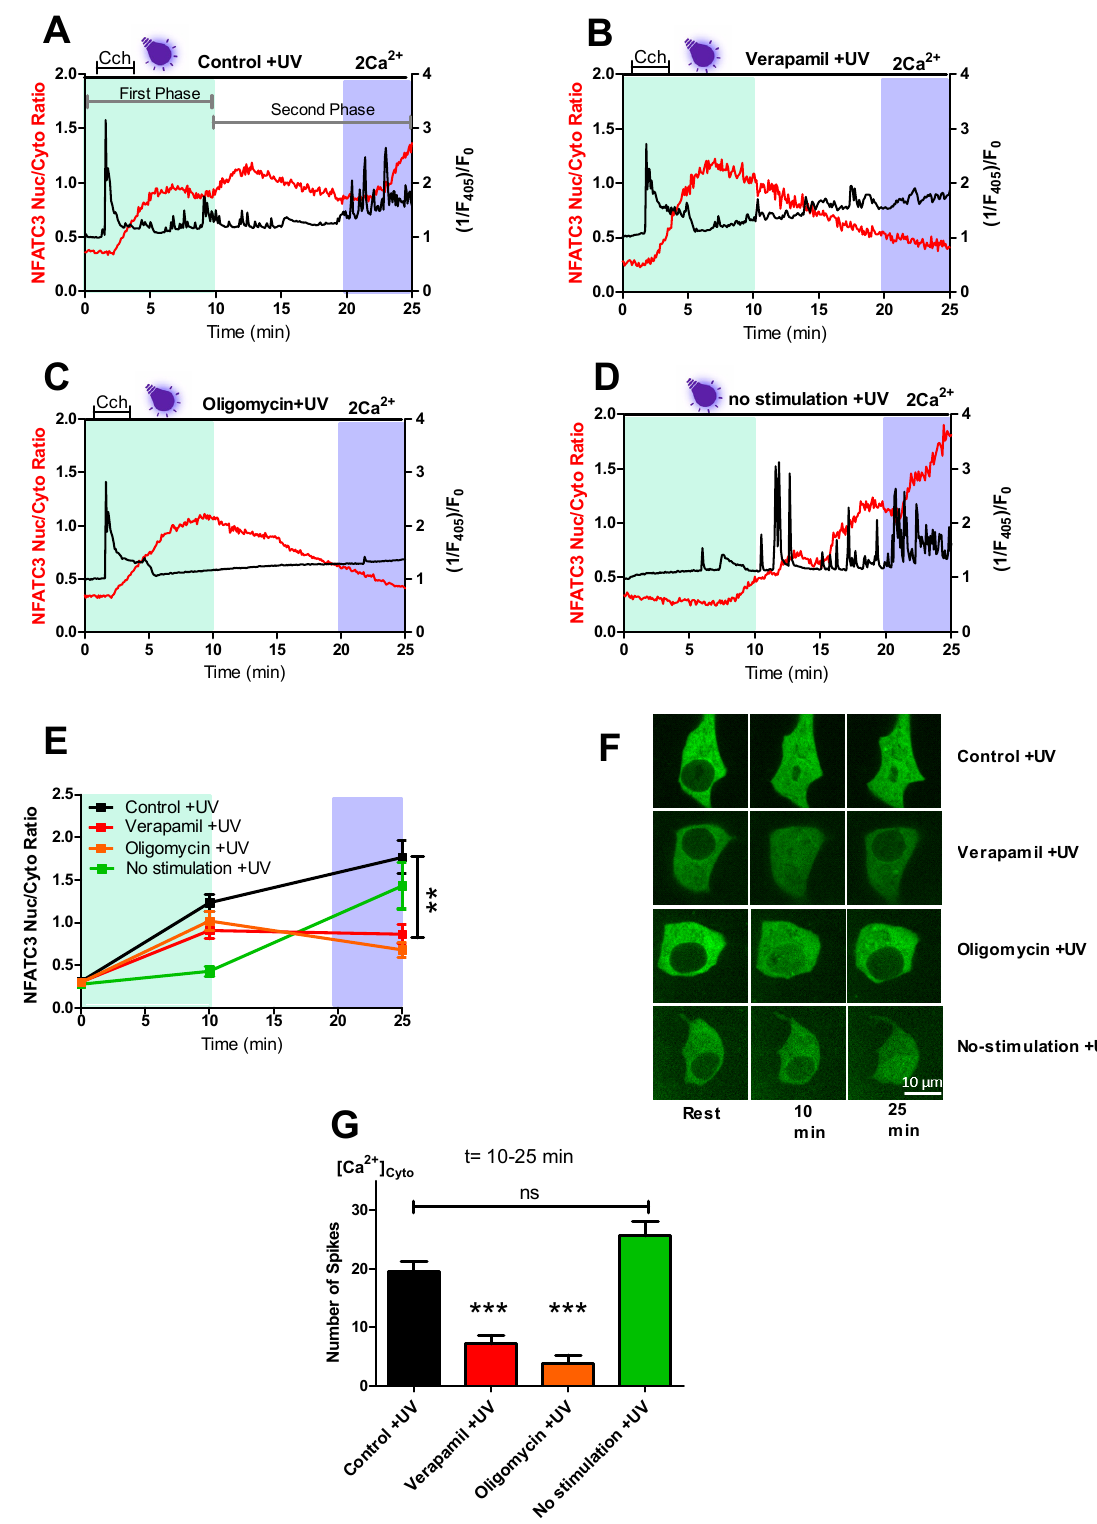
Figure 1. Bi-phasic regulation of nuclear GFP-NFATc3 translocation in INS-1 cells. Representative trace of CCh-induced Ca 2+ rise (black trace) measured with Fura-2 by exciting the cells with 405 nm laser line. Simultaneous GFP-NFATc3